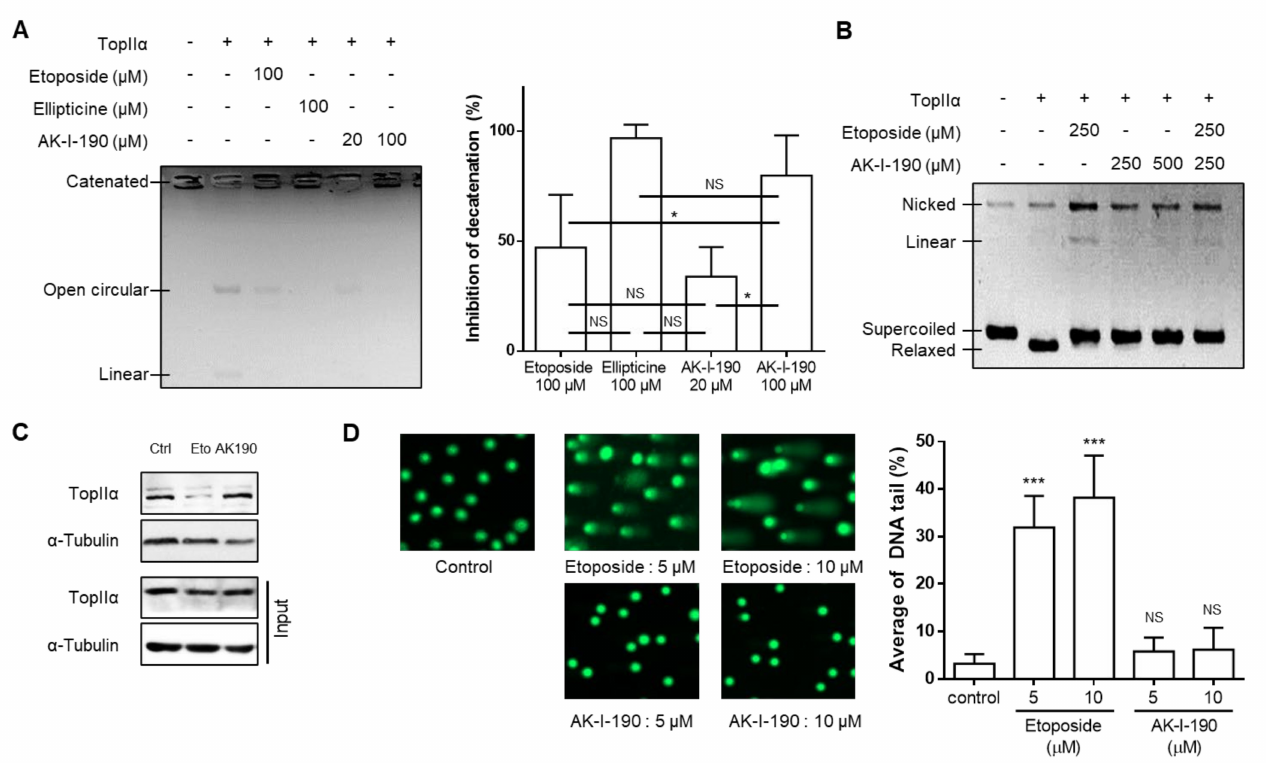
Figure 2. AK-I-190 inhibits topoisomerase II inhibition as a catalytic inhibitor. ( A ) kDNA decatenation assay of AK-I-190. The graph on the right shows quantification of the values measured in the gel. ( B ) Cleavage complex assay. Supercoiled DNA (pBR322) was pre-incubated with DNA topoisomerase II α and the indicated compound was added. After incubation and agarose gel electrophoresis, bands of linear DNA were analyzed. ( C ) Band depletion assay. Formation of topoisomerase II α –DNA cleavage complex was assessed using the band depletion assay. Cells treated with vehicle, etoposide, or AK-I-190 were lysed with denaturing buffer and centrifuged. DNA-unbound topoisomerase II α was evaluated in the supernatant (upper panel). The whole cell lysate in the same experimental condition was used as input. ( D ) Alkaline comet assay. Comet slides were electrophoresed at high pH and stained with a SYBR gold solution. The comet tails were observed by fluorescence microscopy. Quantification of DNA tails was conducted using Komet 5.5 software. The intensities of comet tails versus comet heads reflected the extent of DNA breaks ( n = 50). * p < 0.05 and *** p < 0.001 vs. control; NS, not